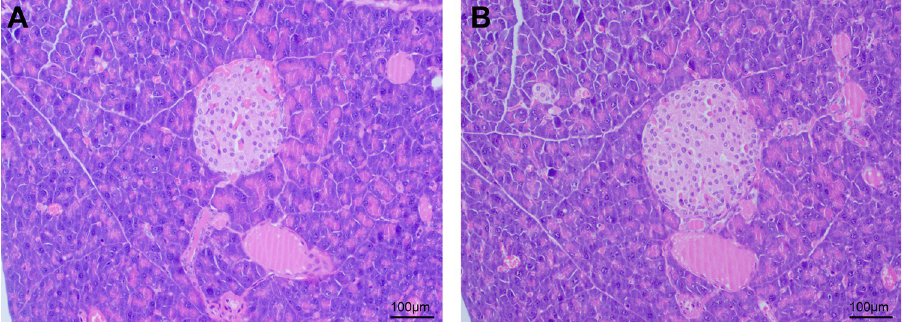
Fig 1. Effect of CIH on the pancreatic tissue. (A) Pancreatic histology of normoxia mice with normal architecture. (B) Pancreatic histology of CIH mice with abnormal pancreatic architecture (magnification × 100).